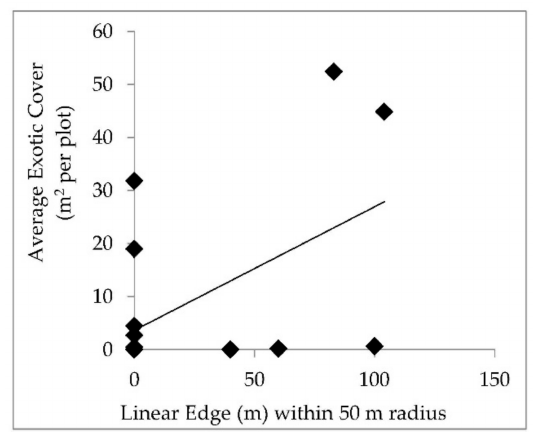
Figure A1. Linear regression of the average total exotic cover (%) prior to disturbance plotted against the amount of linear edge (m) within a 50 m radius of each disturbed plot. y = 0.23 x + 3.69, p -value = 0.022, R 2 = 0.28.